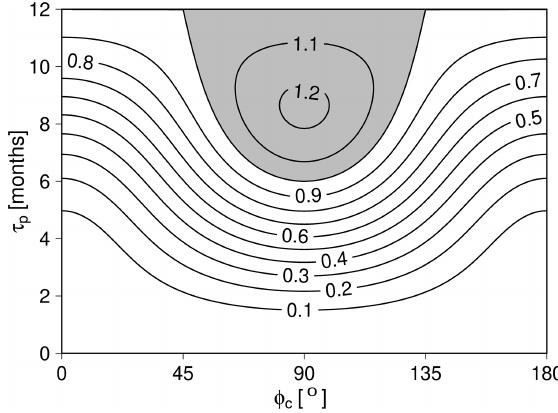
( j ) Figure 4. The white noise variance Var ( (cid:15) ) ( B n ) that is sampled from the seasonal cycle (normalized by the seasonal cycle variance σ 2 c ) for the simplified case without amplitude modulation by orbital variations. The variance is shown as a function of the width of the proxy abundance window τ p and of the seasonal phase φ c , which together characterize proxy seasonality. Values greater than 1 are indicated by gray